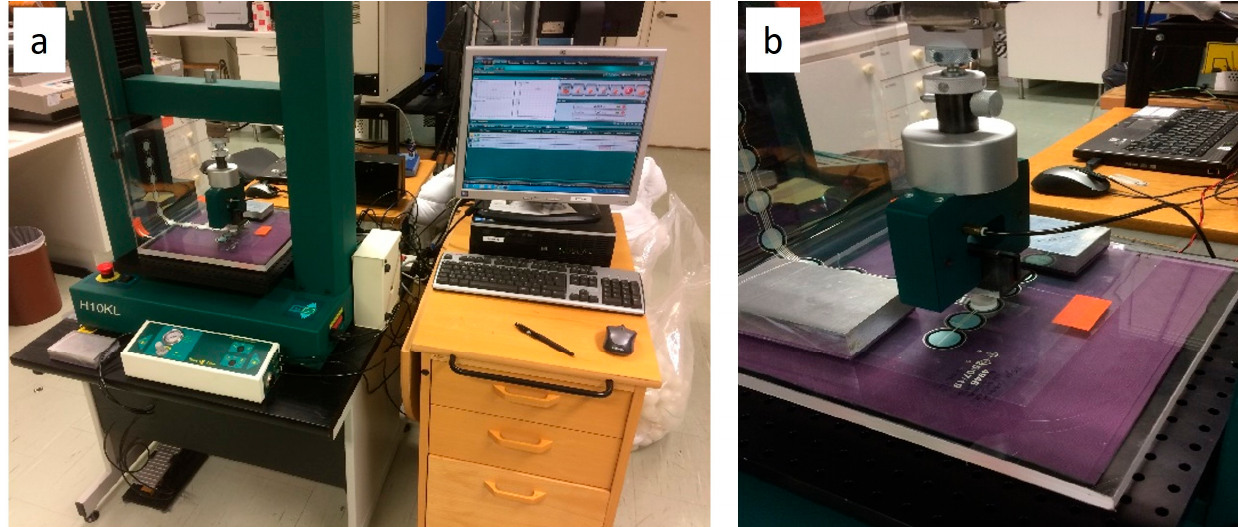
Figure 8. Tinius Olsen tensile tester setup for pressure vs. resistance testing on the flat. Overview of the setup ( a ) and a zoomed in view on the testing of a sensor strip with the contact plate ( b ).